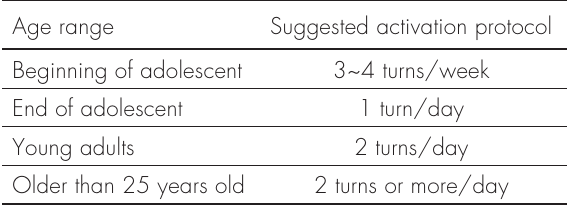
Table I. Activation protocol suggested by Moon et